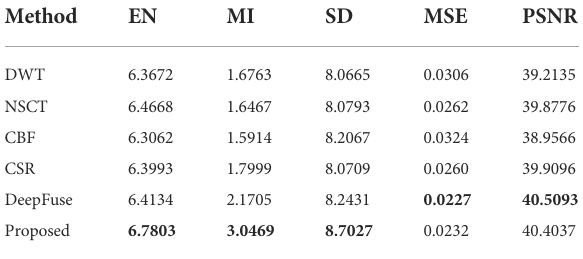
TABLE 4 Comparison results of evaluation metrics for image(c).